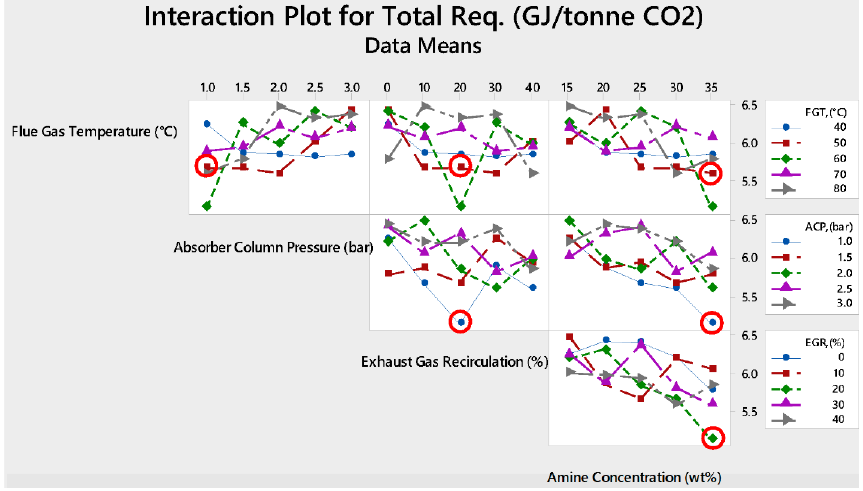
Figure 6. Interaction plot for all factors on the specific energy requirement in the capture unit.